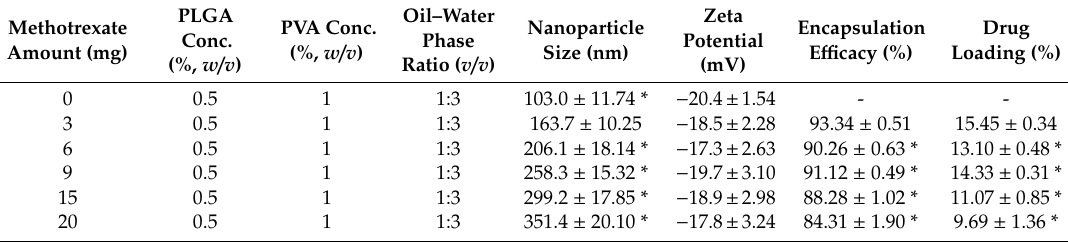
Table 4. Physicochemical and encapsulation characteristics of nanoparticles (NPs) ( n = 5, mean ± SD). Methotrexate Amount